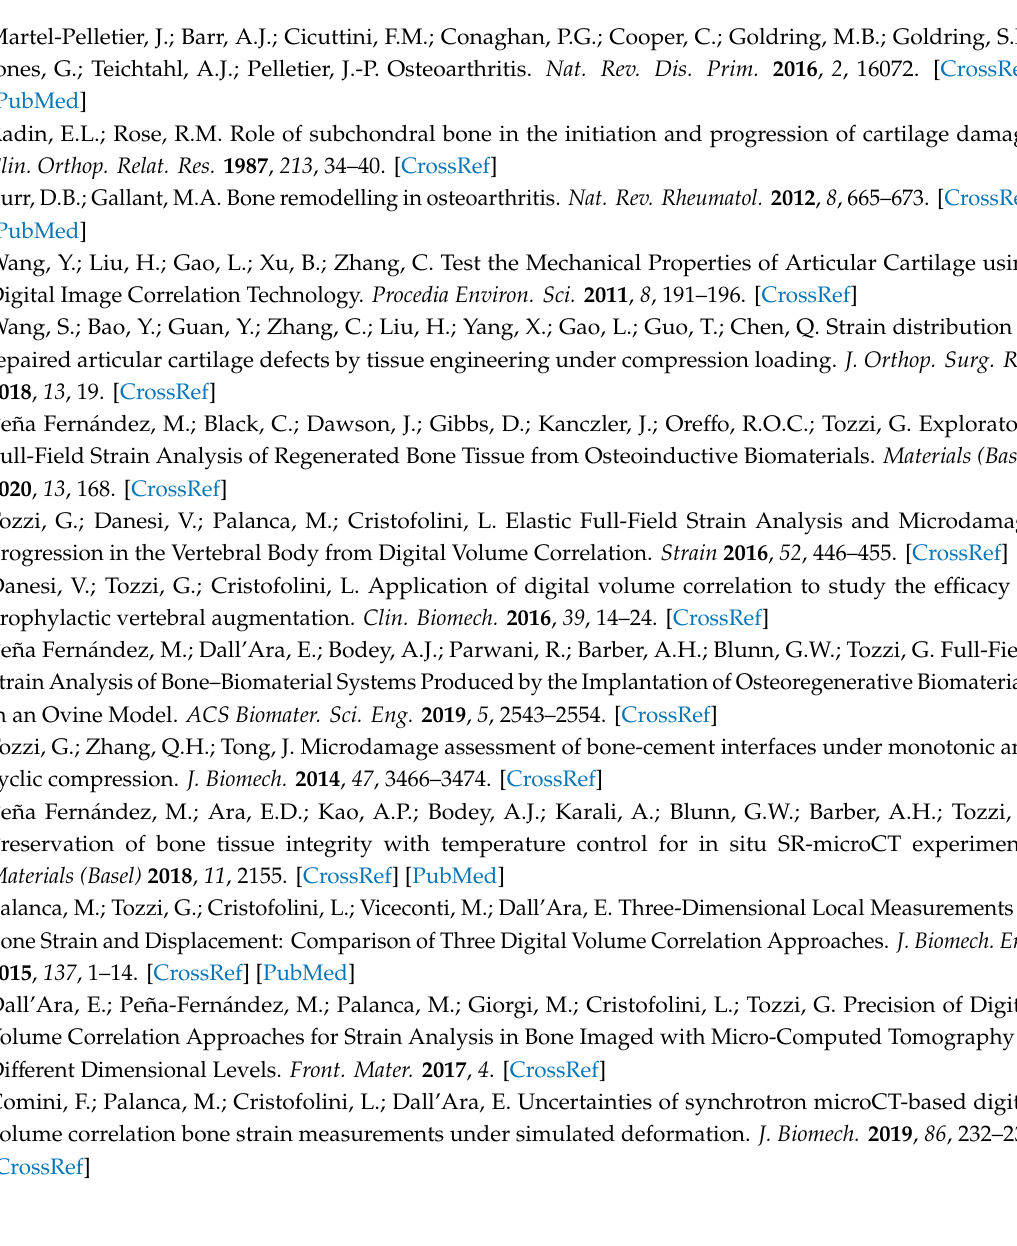
Table S1: Random errors of each strain component in the articular cartilage region, Table S2: Random errors of each strain component in the mineralized